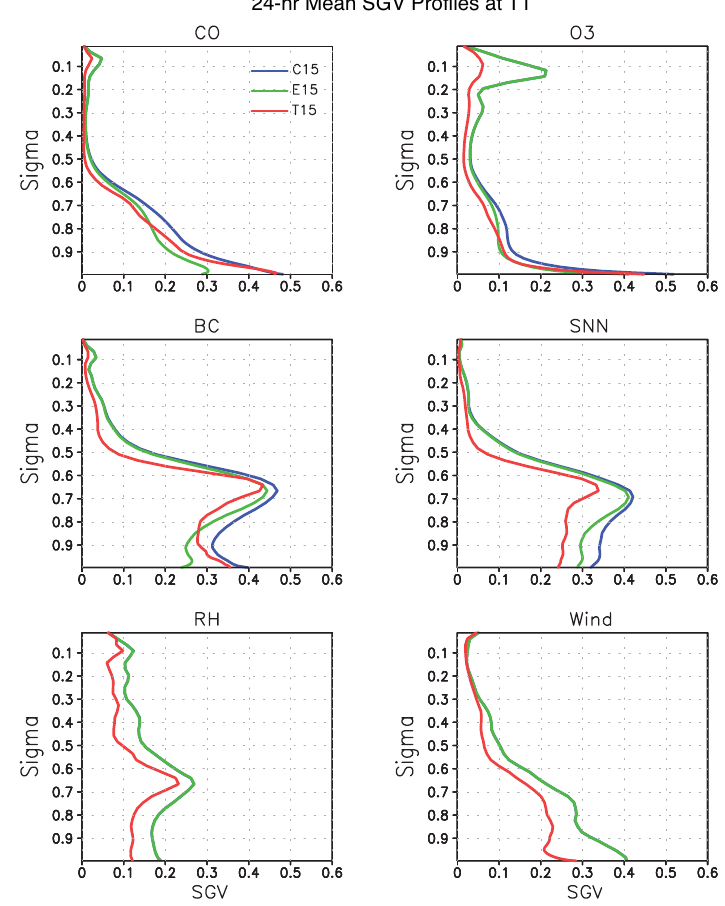
Fig. 16. Comparison of vertical profiles of daily mean SGV simulated in C15, E15, and T15 simulations for CO, O 3 , BC, SNN, RH, and wind speed over the T1 site. The SGV is calculated over the time period 5–30 March